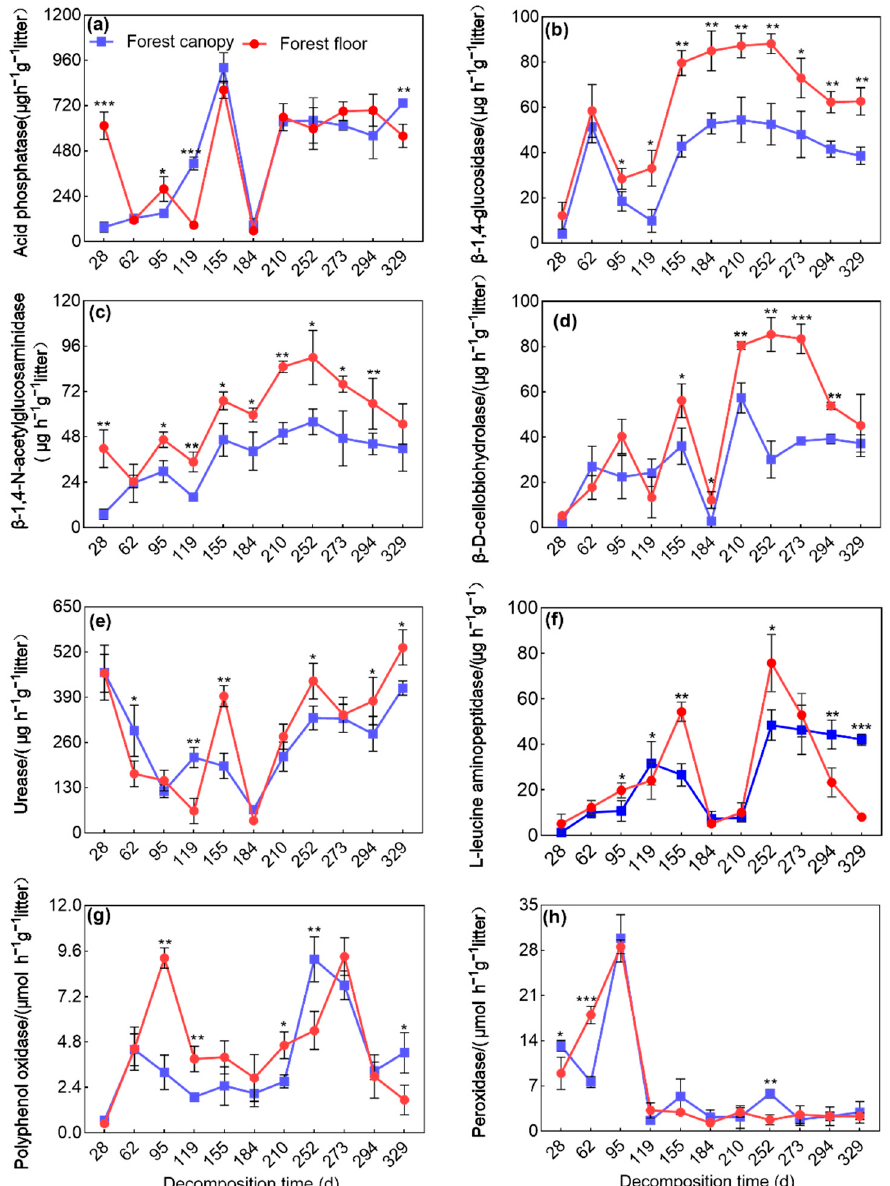
Figure 2. Dynamics of enzyme activities during leaf litter decomposition in the forest canopy and forest floor. Notes: * indicate significant differences in enzyme activities at each sampling time in different habitats. ( p < 0.05 *, p < 0.01 **, p < 0.001 *** ) .